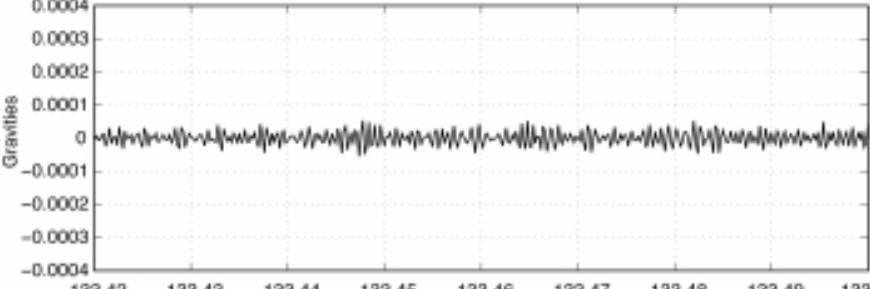
Fig. A4. Event 1 Node 7003 Spectrogram.